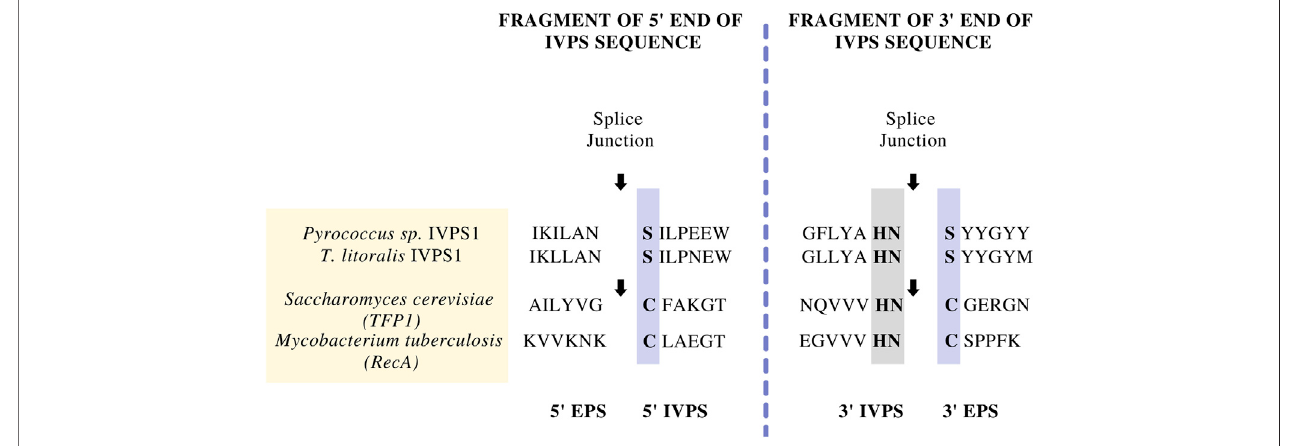
FIGURE 2 | Examples of the amino acid sequences at the protein splice junctions that were used to initially de fi ne intein segments by New England Biolabs team (Comb et al., 1996; Patent No.: US 5496714 A; fi led in 1992, approved in 1996 and expired in 2013). In the splicing mechanism, the N-terminal and C-terminal splice junctionshaveacommonsetofaminoacidsthatareconservedacrossinteinsfoundindifferentorganisms.Thesplicejunctionsareindicatedbyarrows,whileconserved amino acids involved in the splicing mechanism are boxed (see also Hirata et al., 1990; Kane et al., 1990; Davis et al., 1992; Hodges et al.,